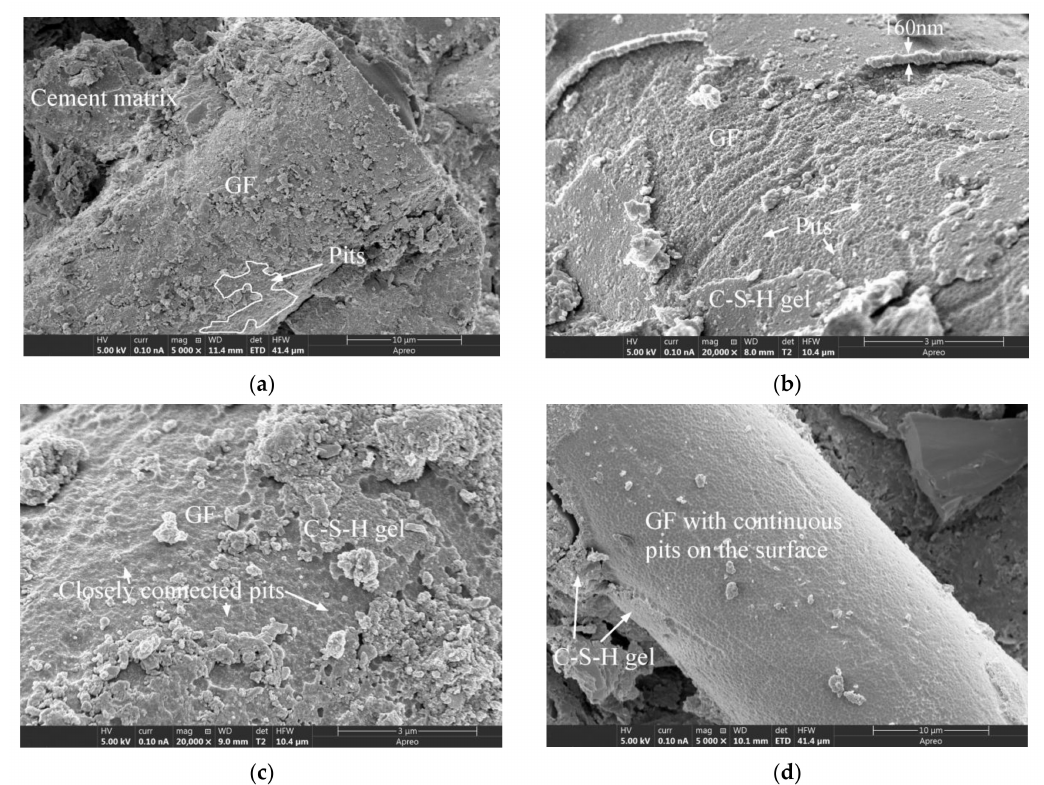
Figure 9. The SEM images of GFRC specimens: ( a ) GF-30-135; ( b ) GF-30-90; ( c ) GF-30-90; ( d )